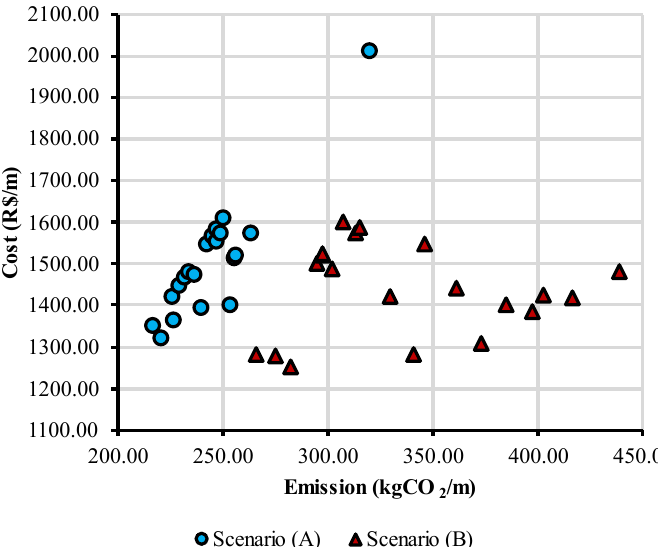
Figure 6. Pareto front for emissions and cost of the structure.